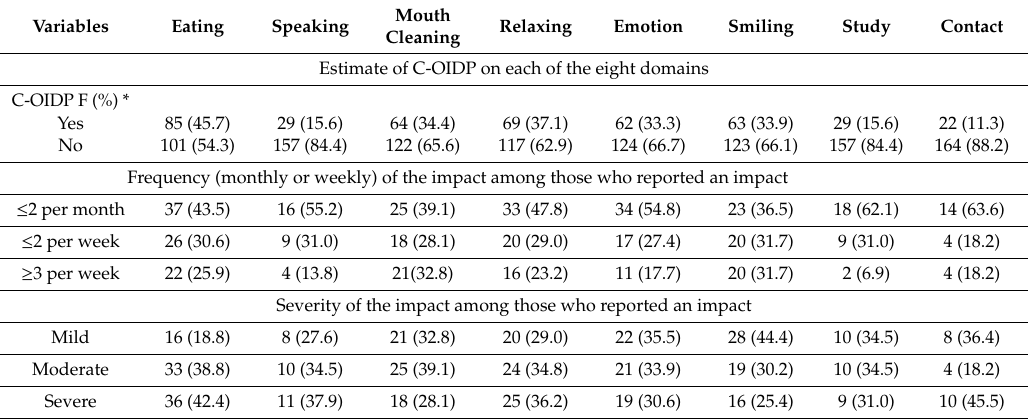
Table 2. The Oral Impact on Daily Performance (estimate, frequency, and severity) among children in Madinah, SA ( n = 186).